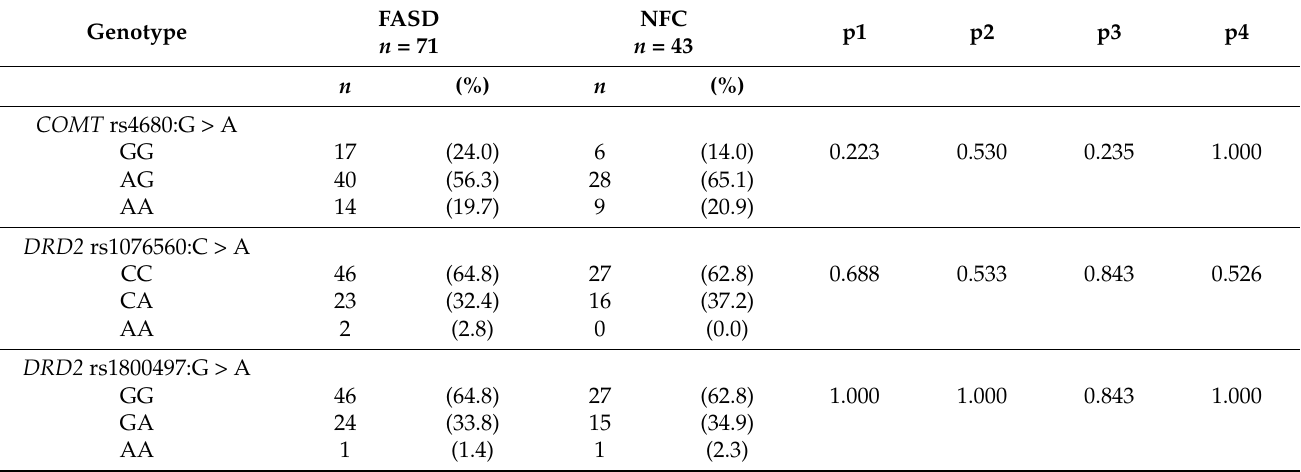
Table 4. Genotype distribution of the studied COMT and DRD2 SNPs in FASD and NFC groups.